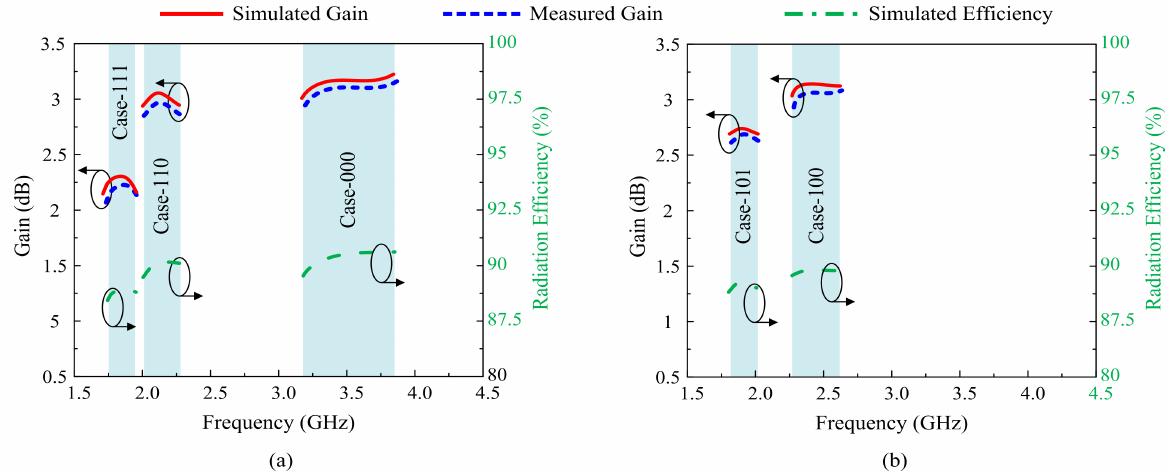
Figure 17. Gain and radiation efficiency of the antenna for the various switching states. ( a ) Case 00, Case 110, and Case 111. ( b ) Case 100 and Case